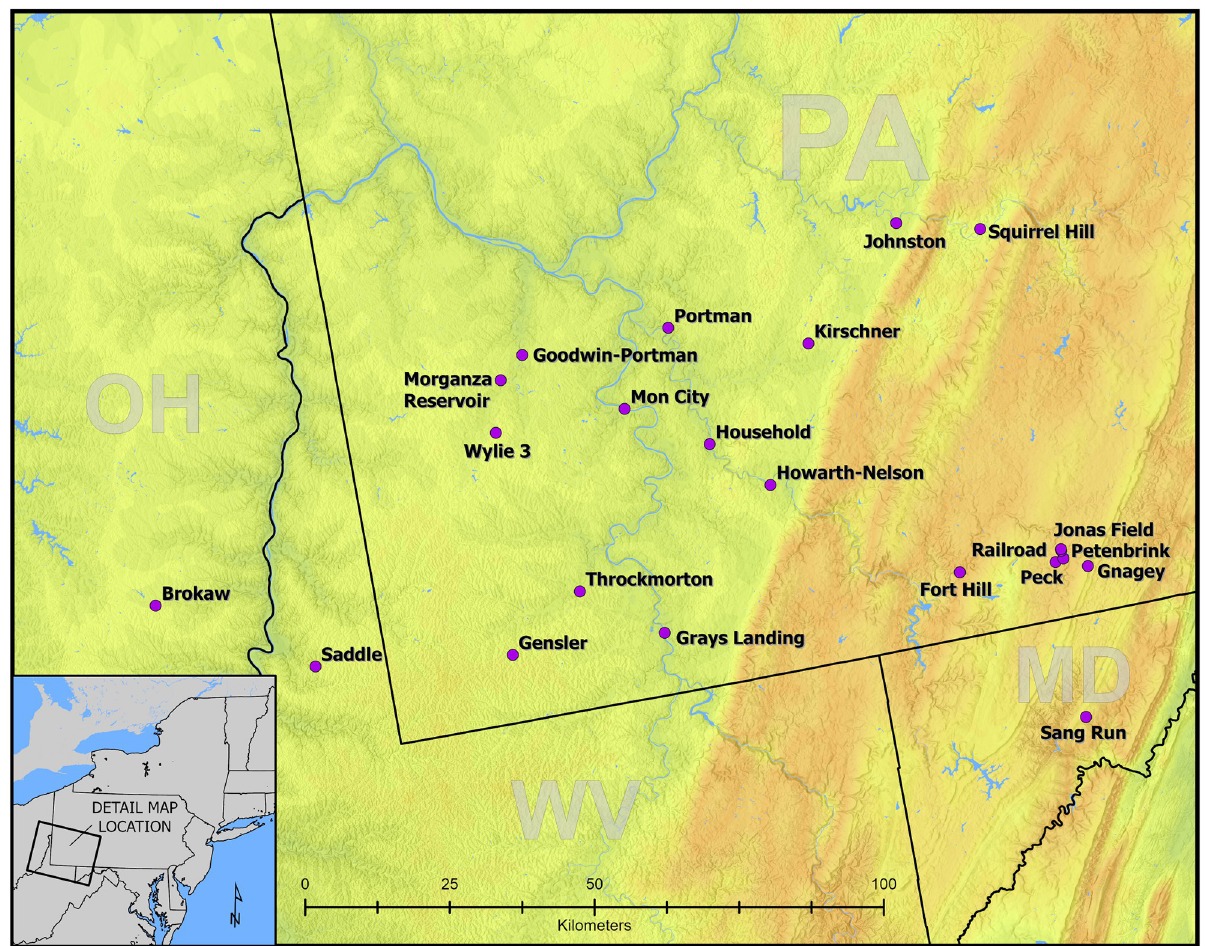
Fig 1. Locations of sites with radiocarbon dates used in the Bayesian modeling. This map was produced in ArcGIS v 10.6 at the New York State Museum in Albany by compiling GIS shapefiles obtained from publicly available sources including Statistics Canada, the United States Census, and the United States Geological